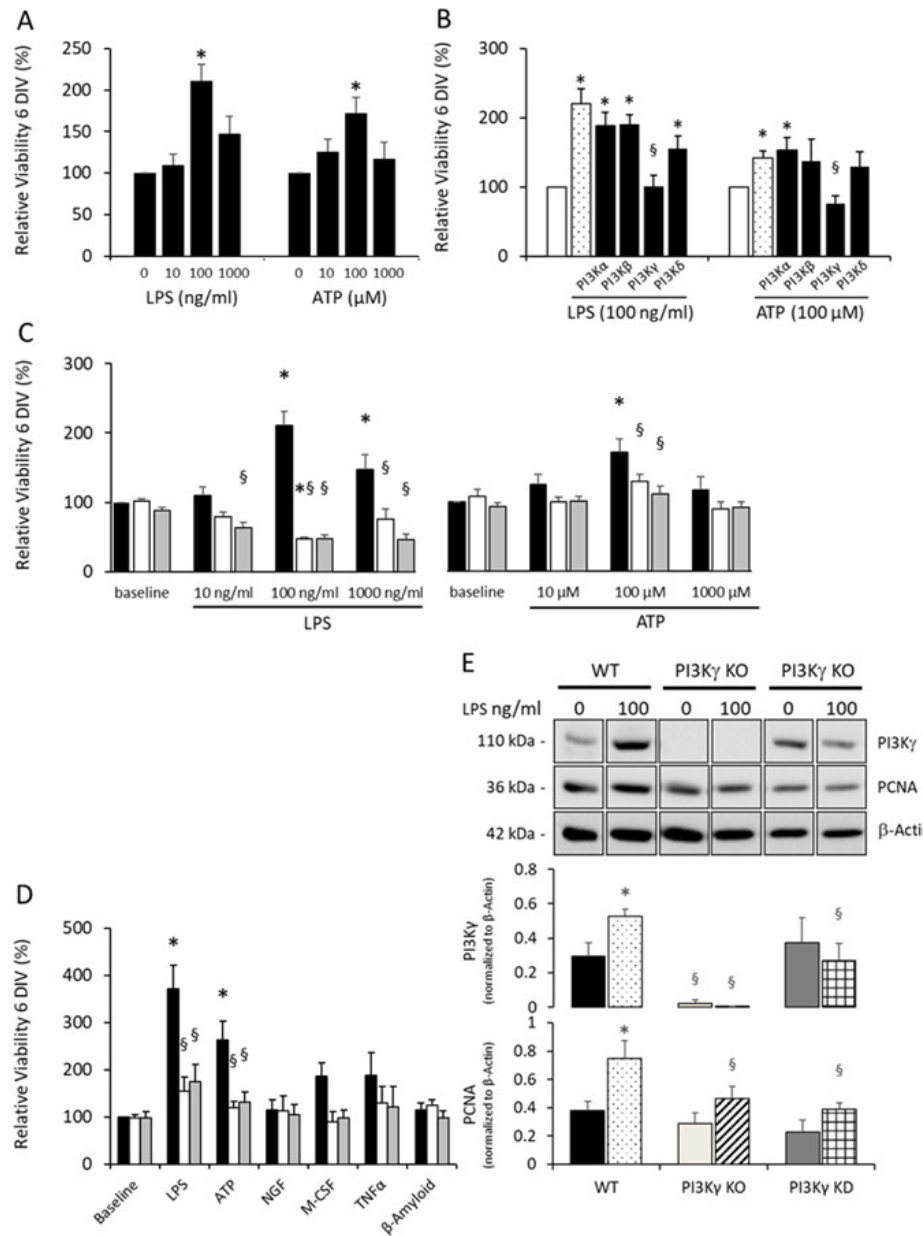
Figure 1. PI3K γ mediates pattern recognition receptor-induced microglial viability and proliferation. ( A ) Microglia derived from wild-type mice (WT) were seeded (5000 cells/well) in a 96-well plate and incubated with indicated concentrations of LPS or ATP for 6 days. Proliferation was measured by using an MTT assay. n = 5 − 6, * p < 0.05, compared to unstimulated cells. ( B ) Primary microglia derived from wild-type mice were seeded (5000 cells/well) in a 96-well plate and pretreated for 60 min with selective inhibitors targeting lipid kinase activity of PI3K α (A66; 300 nM), PI3K β (TGX221; 200 nM), PI3K γ (AS605240; 1 µ M) or PI3K δ (IC87114; 2 µ M). Subsequently, cells were incubated with LPS (100 ng/mL) or ATP (100 µ M) for 6 days. Cellular viability was measured by using an MTT assay. n = 9, each, * p < 0.05, compared to untreated microglial cells (open columns); § p < 0.05, compared to mock 60 min-pretreated microglial cells (dotted columns). ( C ) Microglia obtained from wild-type (black columns), PI3K γ knockout (white columns) and PI3K γ lipid